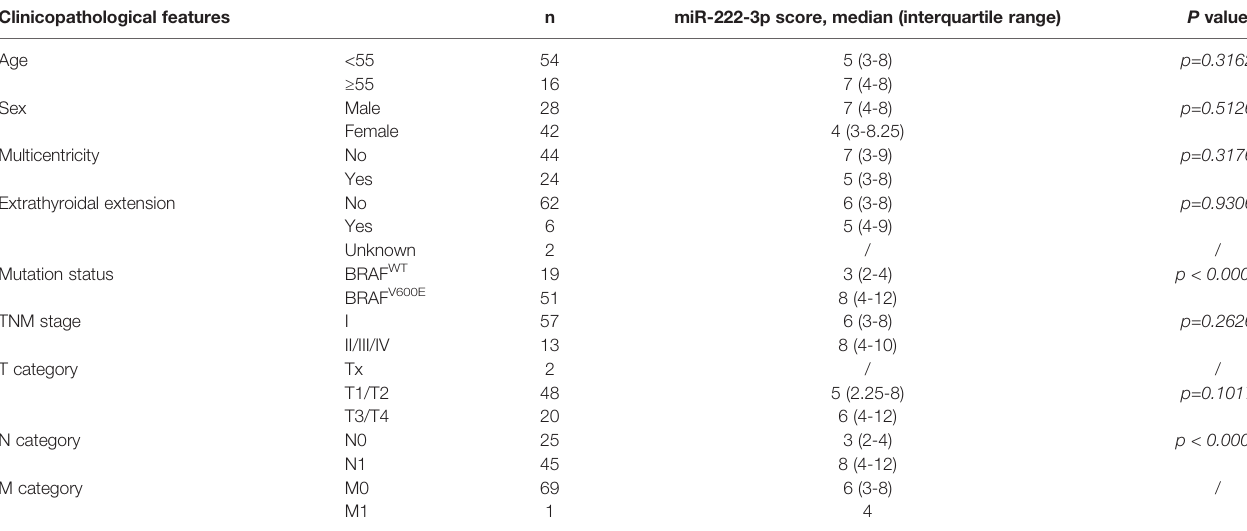
TABLE 1 | Association between miR-222-3p expression and clinicopathological features in PTC. Clinicopathological features